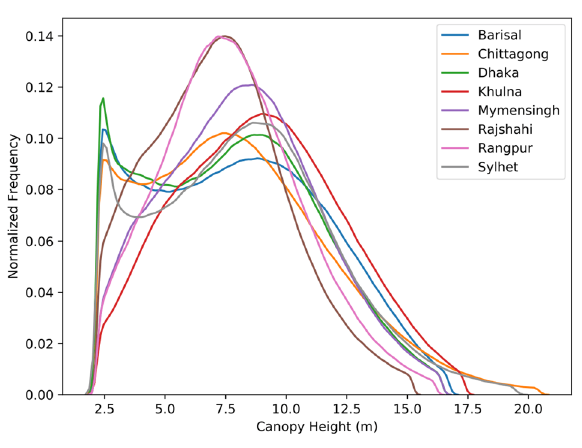
Figure 3. Distribution of TOF height for each division in Bangladesh. Minimum heights are 2.19 m and maximum heights are limited to the 99th percentile.